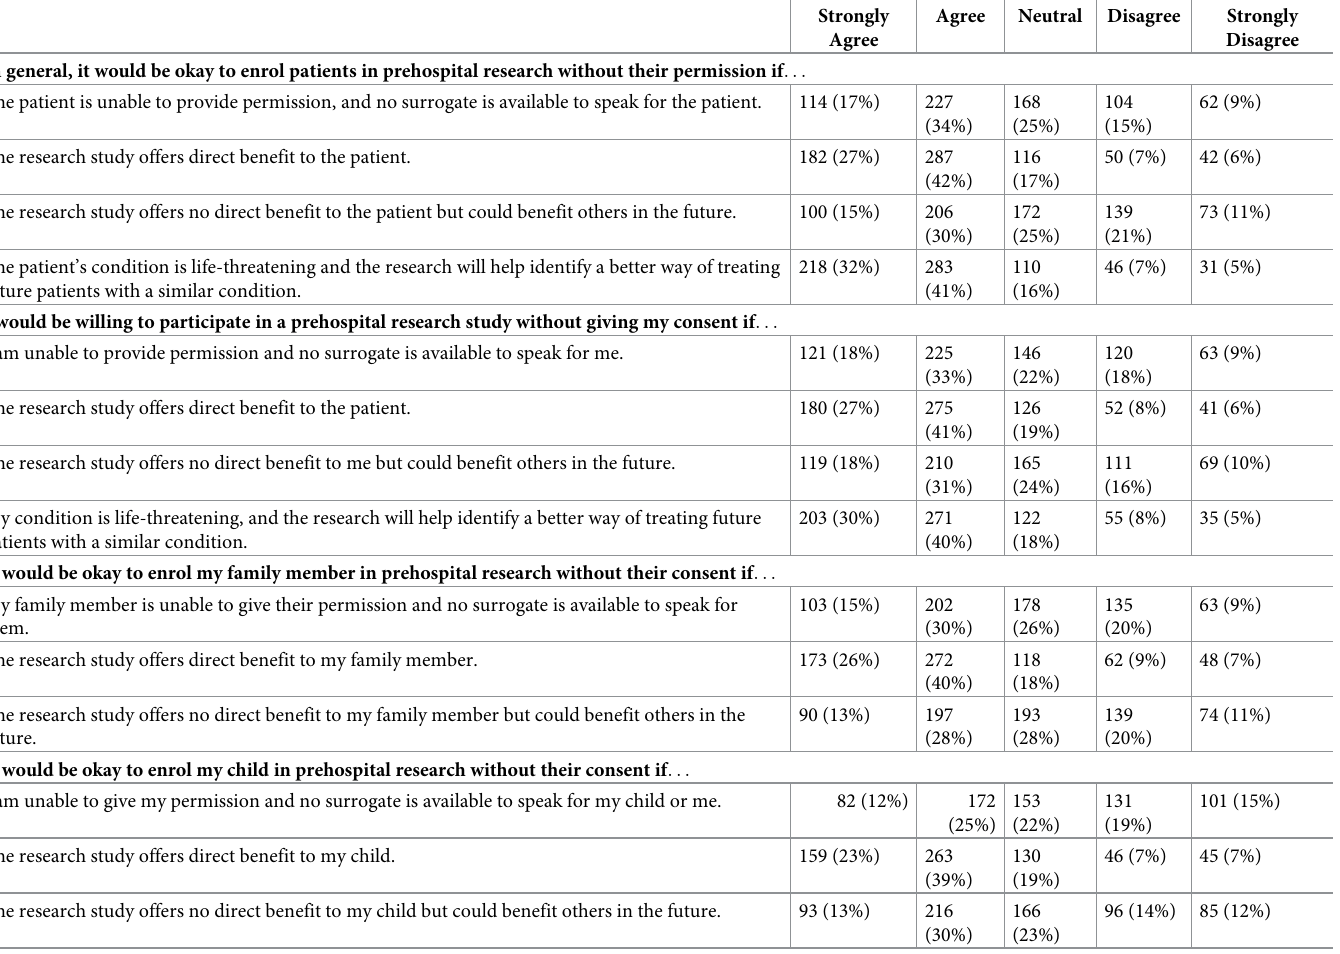
Table 3. Views on delayed consent for prehospital emergency care research under various